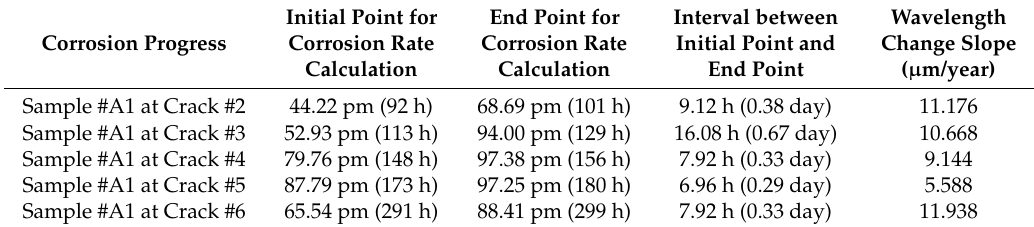
Table 6. Corrosion rate after micro crack formation in hard coating.